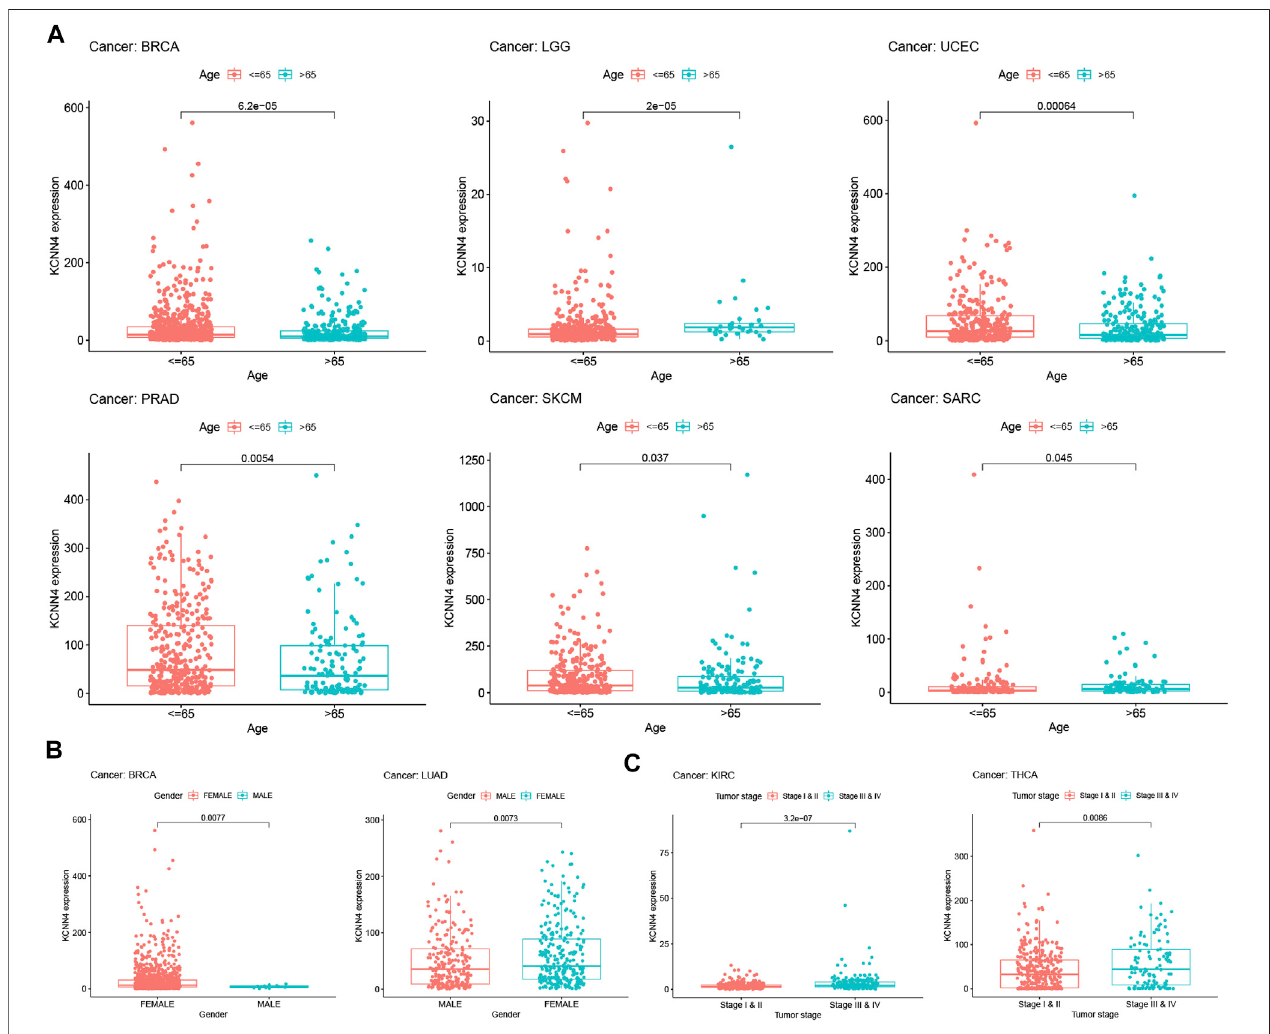
FIGURE 6 | Correlation between KCNN4 expression level and clinical annotations. (A) Correlation between KCNN4 expression level and ages in SKCM, UCEC, PRAD, BRCA, LGG, and SARC. (B) Correlation between KCNN4 expression level and gender in BRCA, and LUAD. (C) Correlation between KCNN4 expression level and tumor stages in KIRC, and